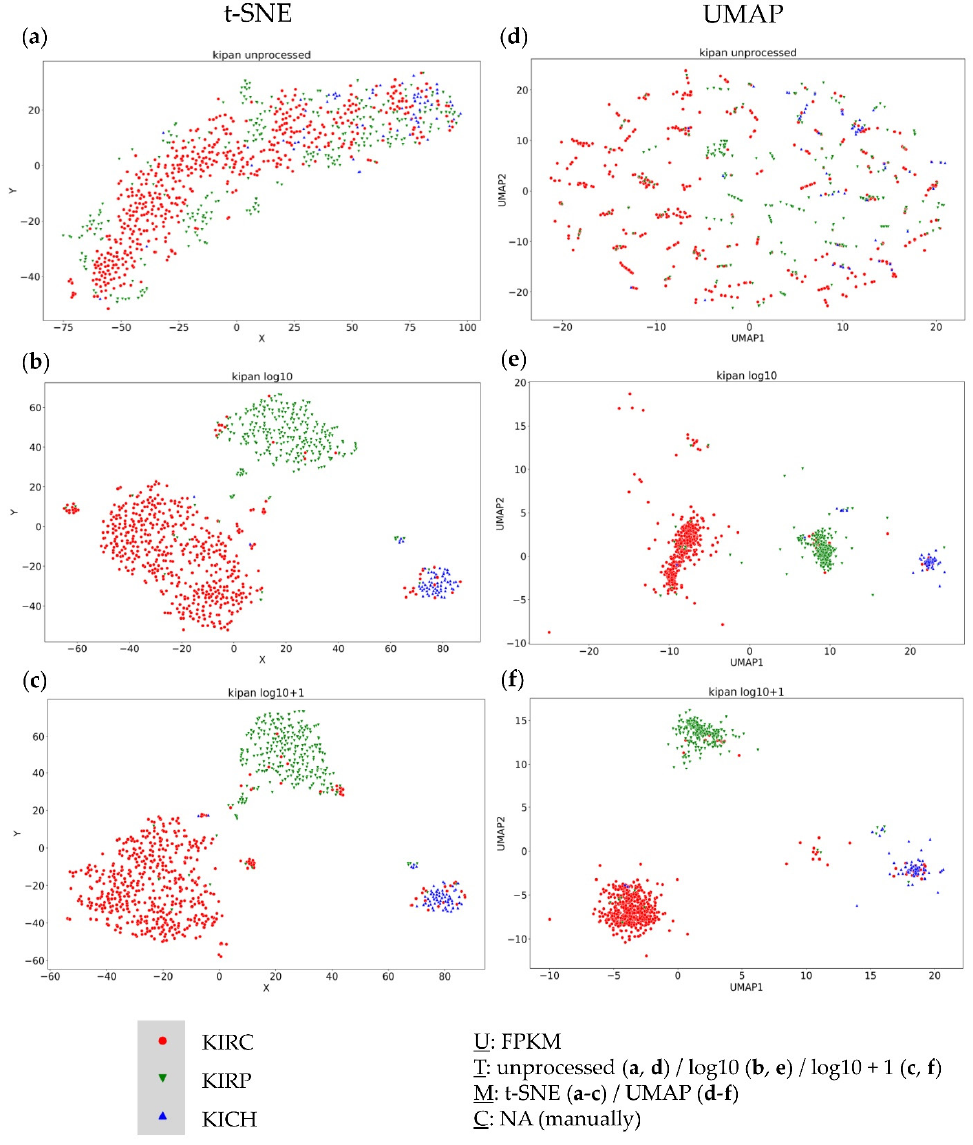
Figure 4. Visual clustering of the TCGA-KIPAN dataset consisting of the three major histopathologic subgroups of renal cell carcinoma (RCC)—clear cell RCC (KIRC), papillary RCC (KIRP), and chromophobe RCC (KICH)—by applying different data dimension reduction methods. t-SNE plot approach for ( a ) unprocessed, ( b ) log10 transformed, and ( c ) log10 + 1 transformed FPKM values and UMAP approach using ( d ) unprocessed, ( e ) log10 transformed, and ( f ) log10 + 1 transformed FPKM values. FPKM: Fragments Per Kilobase Million; U: unit, T: transformation, M: data dimension reduction method, C: clustering method, NA: not applicable.